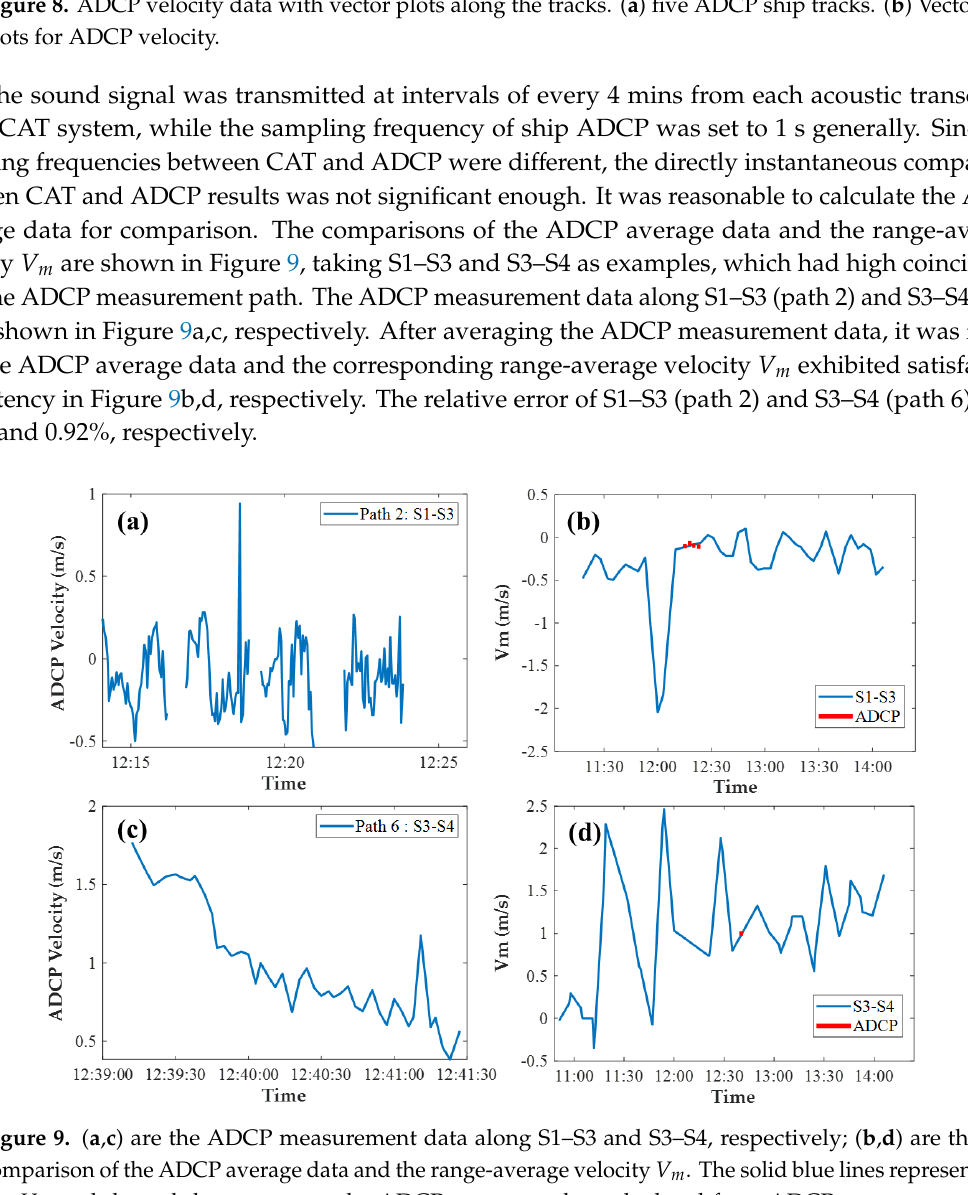
Figure 8. ADCP velocity data with vector plots along the tracks. ( a ) five ADCP ship tracks. ( b ) Vector plots for ADCP velocity.